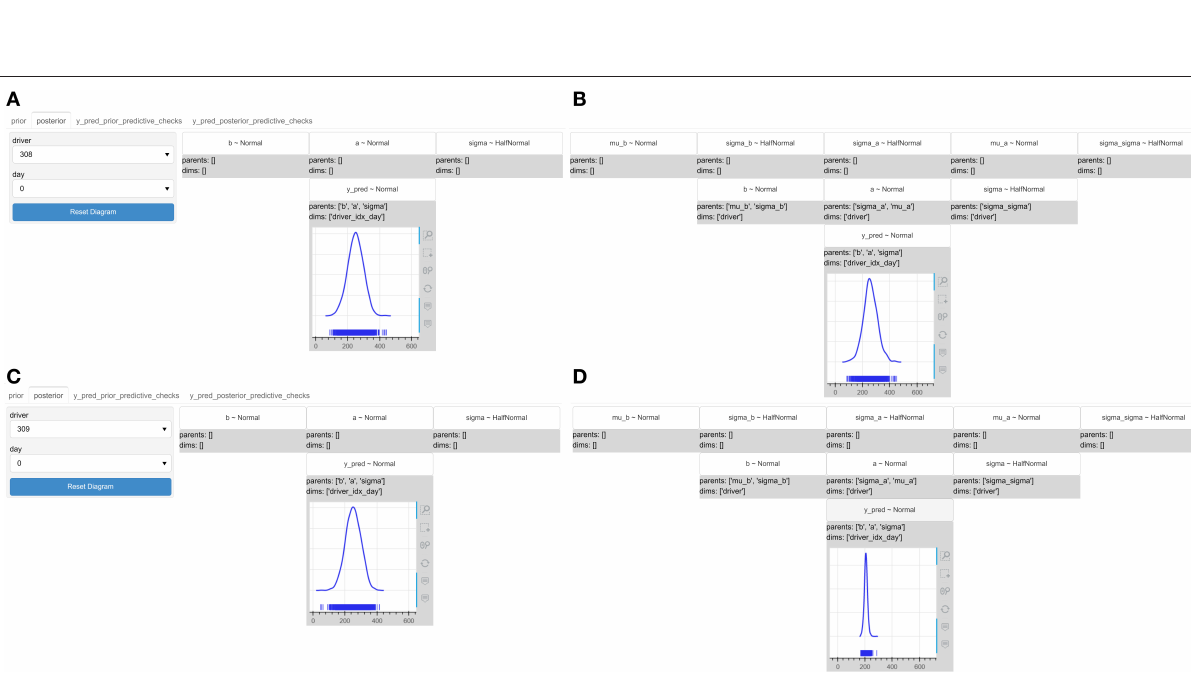
Frontiers in Computer Science |